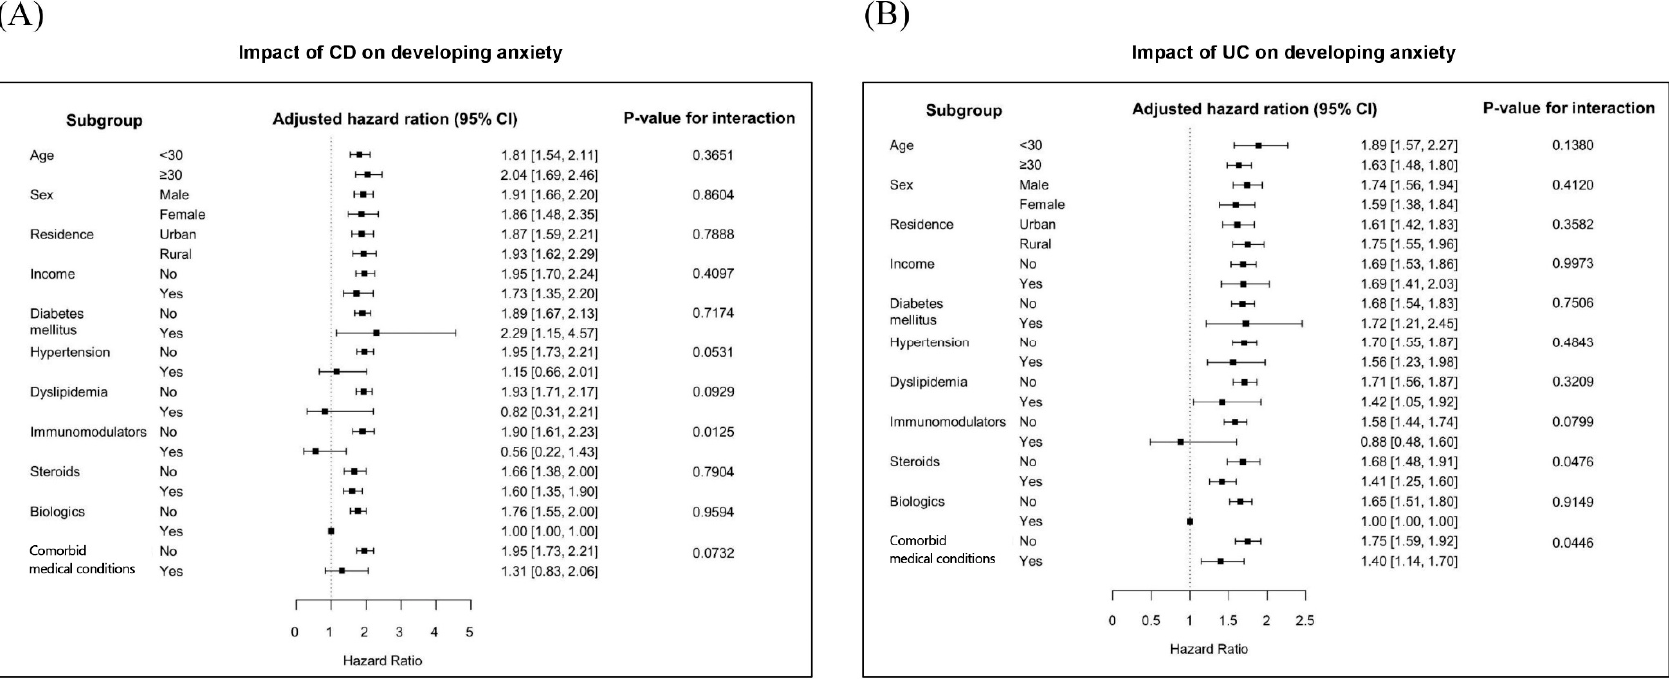
Figure 2. Subgroup analysis for the risk of anxiety in patients with ( A ) Crohn’s disease; and ( B ) ulcerative colitis compared to control groups. CD, Crohn’s disease; CI, confidence interval; UC, ulcerative colitis.